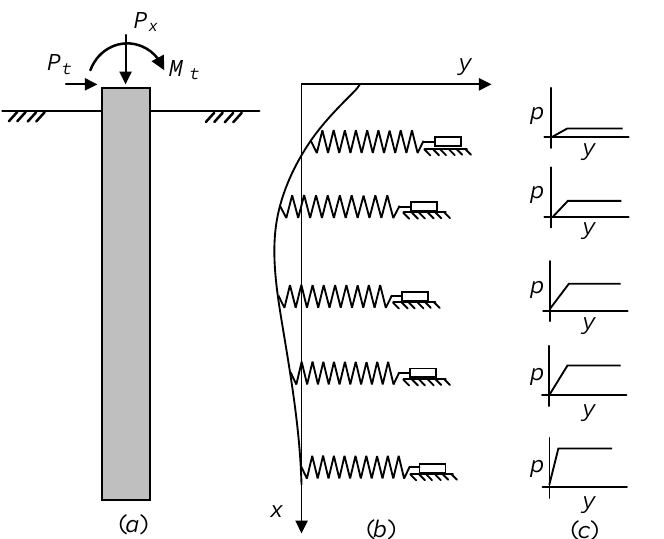
Figure 1. Simplified model of rock mass around the pile: ( a ) Profile View; ( b ) Discrete Spring; ( c ) p – y Curves at Different Depth.